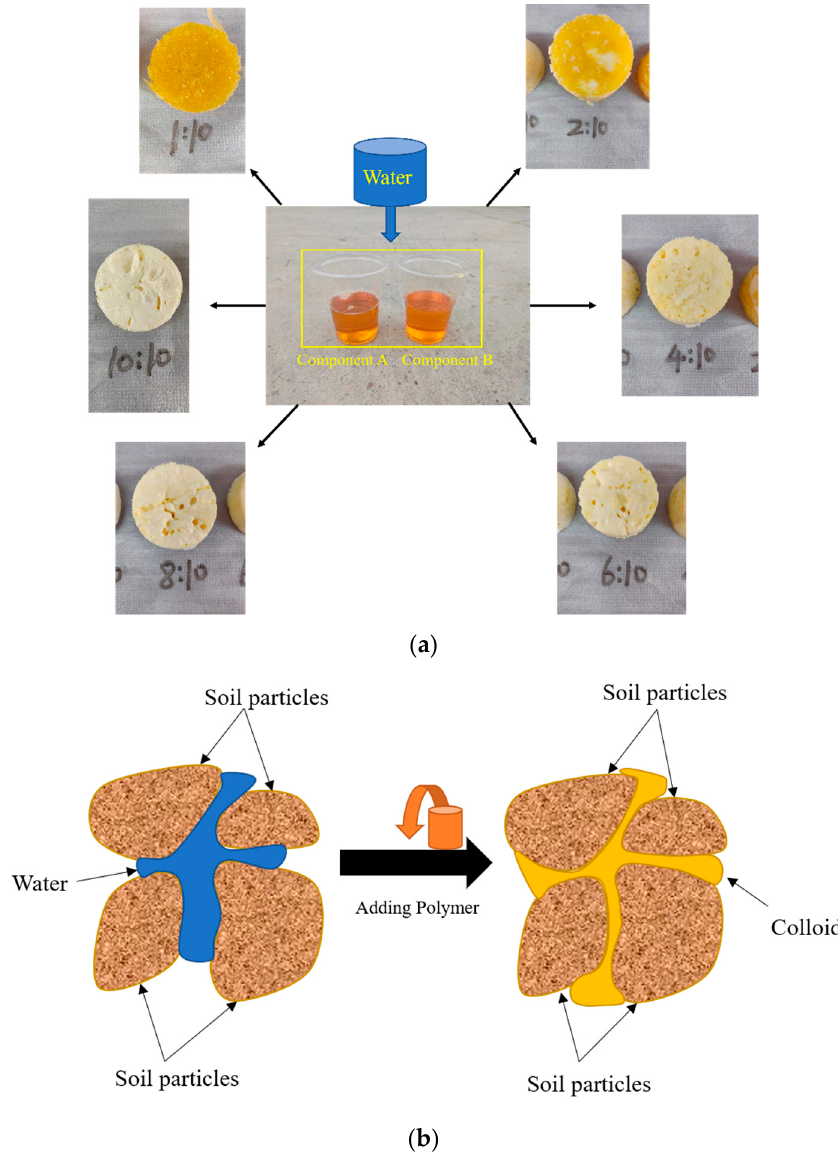
Figure 2. Polymers and solidification mechanism. ( a ) Permeable polymer and hydration products at different water contents. ( b ) Solidification mechanism.